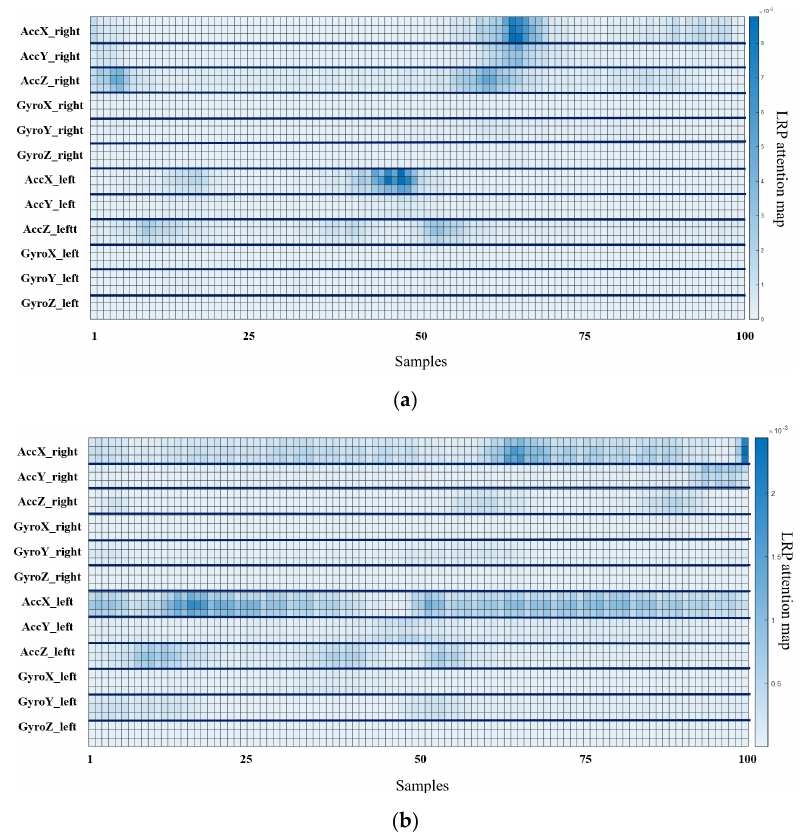
Figure 7. Layer2 result of applying LRP, Grad-CAM, and Relevance-CAM to ResNet50.